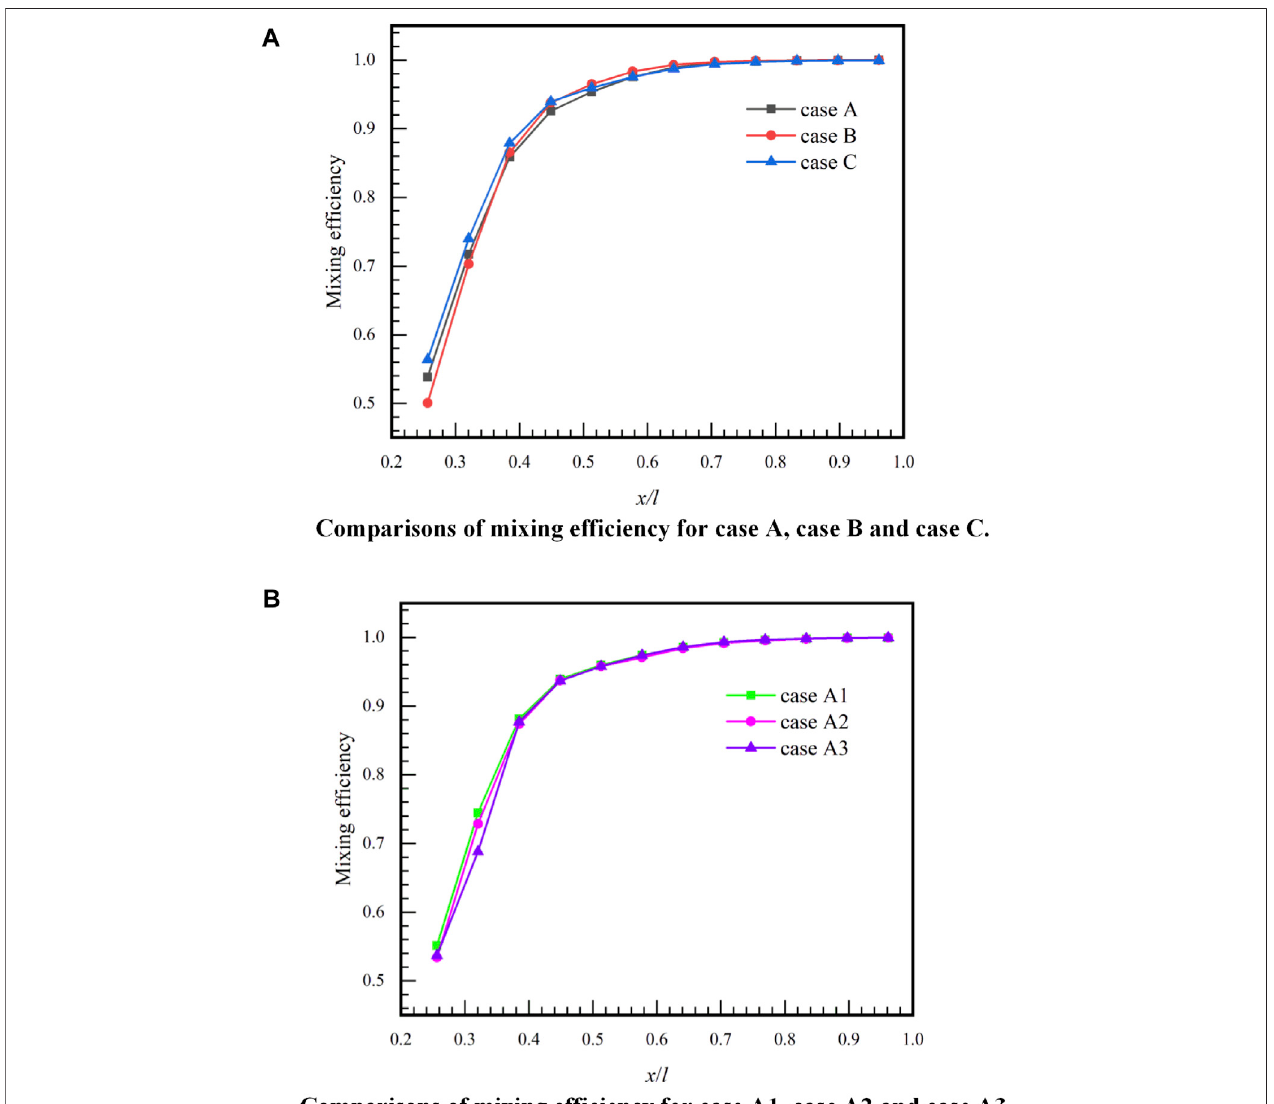
FIGURE 11 | Comparisons of mixing ef fi ciency distributions for all cases. Each datum is obtained by averaging all the results on the y-z sections along the streamwise direction. (a) Comparisons ofpressure mixing ef fi ciency for case A, case B, and case C. (b) Comparisons of pressure mixing ef fi ciency for case A1, case A2, and case